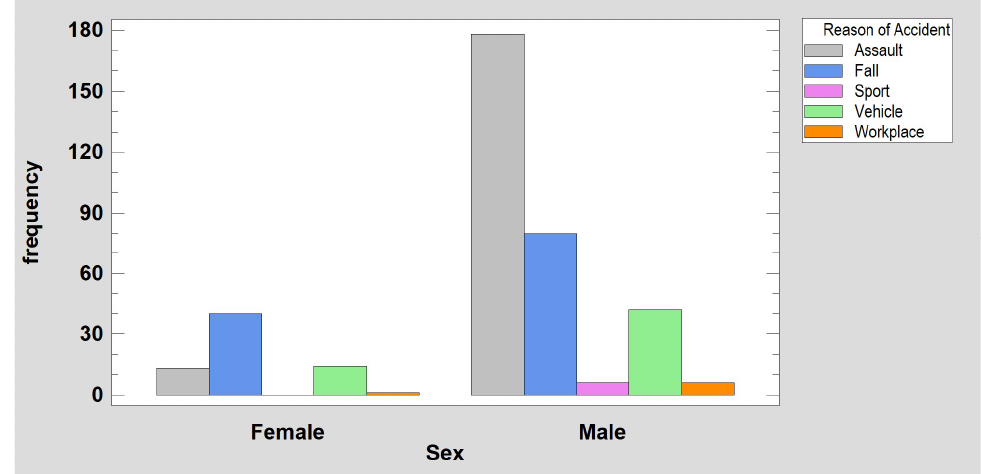
Figure 2. Distribution of causes of mandibular fractures by sex. Women had significantly more fractures due to falls, and men had significantly more fractures due to assaults ( p < 0.001). Table 1. Detailed reasons for mandibular fractures (%, χ 2 test of independence).